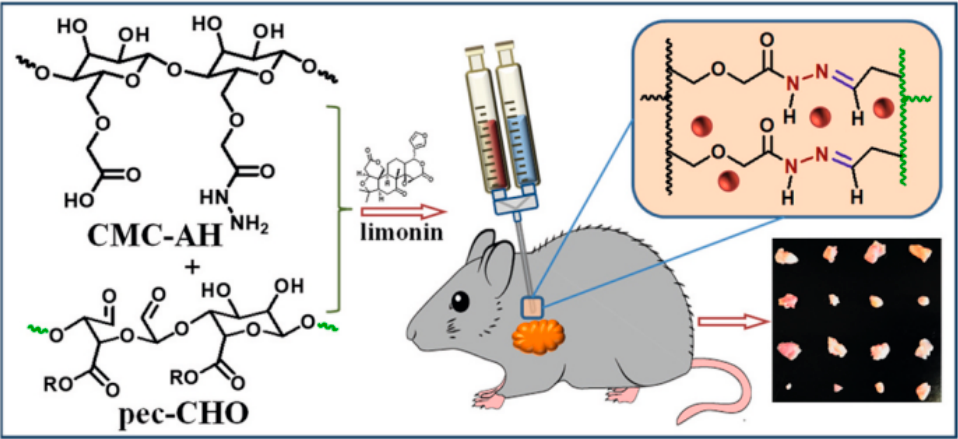
Figure 10. Scheme for the limonin loaded hydrogels for lung cancer treatment. Reproduced with permission [77].